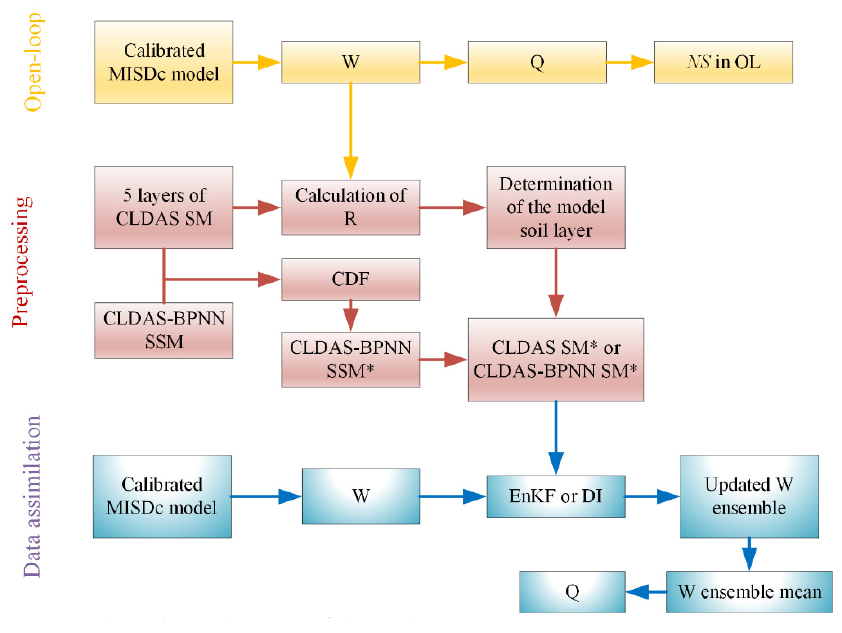
Figure 5. Flow chart schematic of the study.